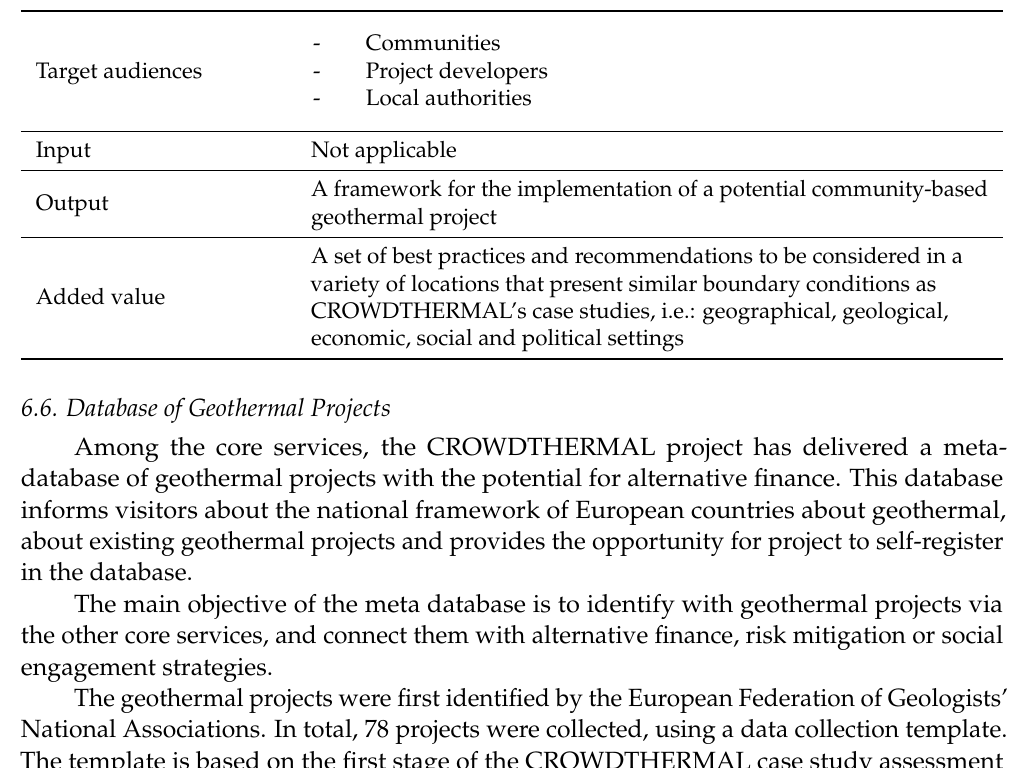
Table 8. Framework for community-based